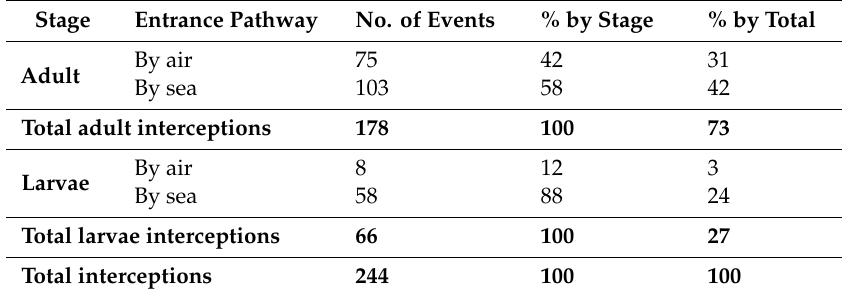
Table 4. Development stages and pathways of mosquito interception events in New Zealand, July 2001–March